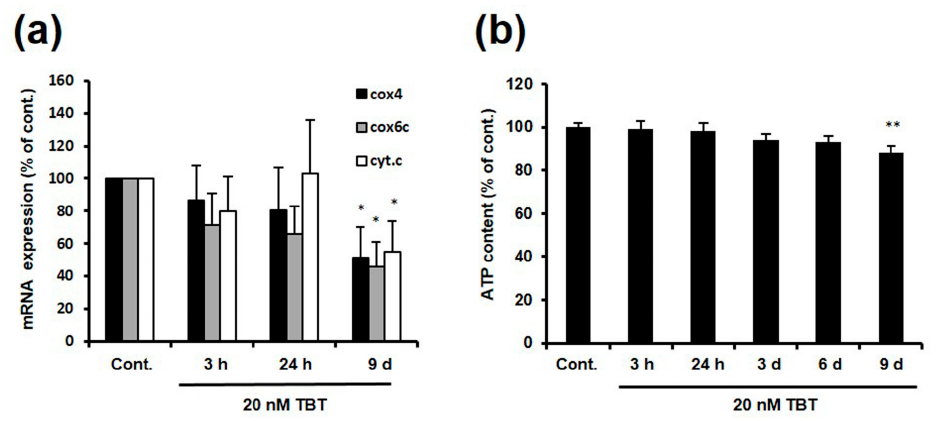
Figure 3. TBT-induced changes in COX4, COX6c, and cyt.c mRNA expression, and intracellular ATP content. ( a ) Cortical neurons were exposed to DMSO or 20 nM TBT for various times, and then the mRNA expression of cyt.c, COX4, and COX6c was measured by real-time PCR. The data are expressed as the mean + S.E.M. ( n = 3). * p < 0.05 vs. control; ( b ) Cortical neurons were exposed to 20 nM TBT for various times, and the intracellular ATP content was measured. The data are expressed as + S.E.M. ( n = 24–32). ** p < 0.01 vs. control.